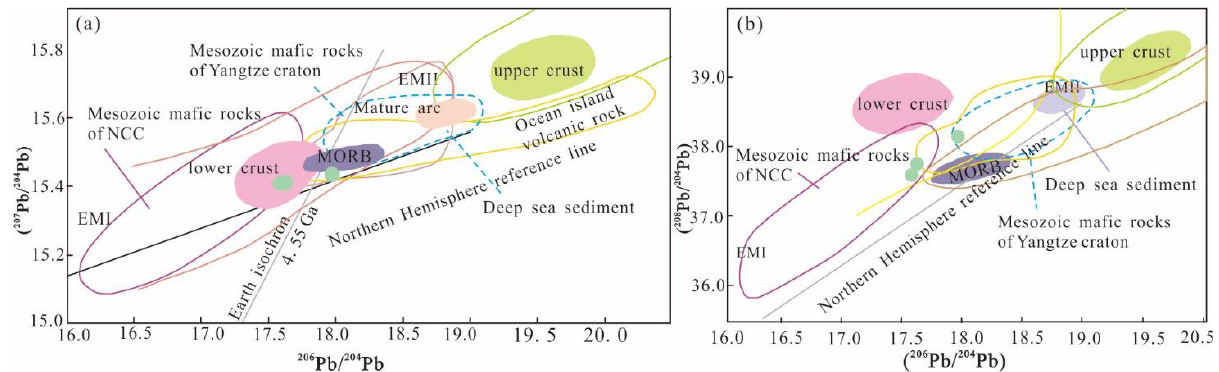
Figure 9. Pb isotopic compositions of the quartz monzonites from the Jinling area, western Shandong province. ( a ): The diagram of 206 Pb/ 204 Pb vs. 207 Pb/ 204 Pb ( b ): The diagram of 206 Pb/ 204 Pb vs. 208 Pb/ 204 Pb